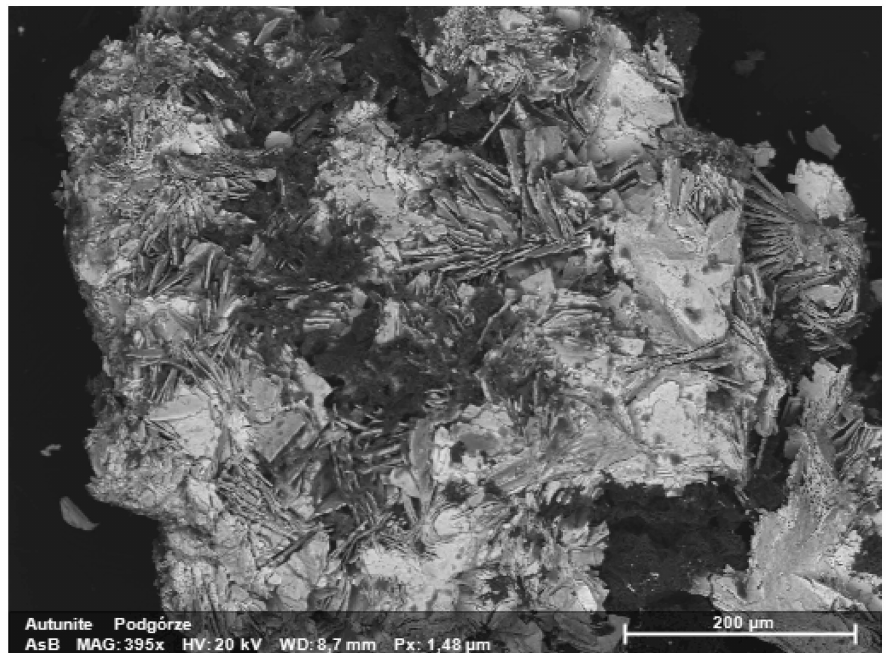
Figure 8. Aggregates of tabular autunite crystals (SEM